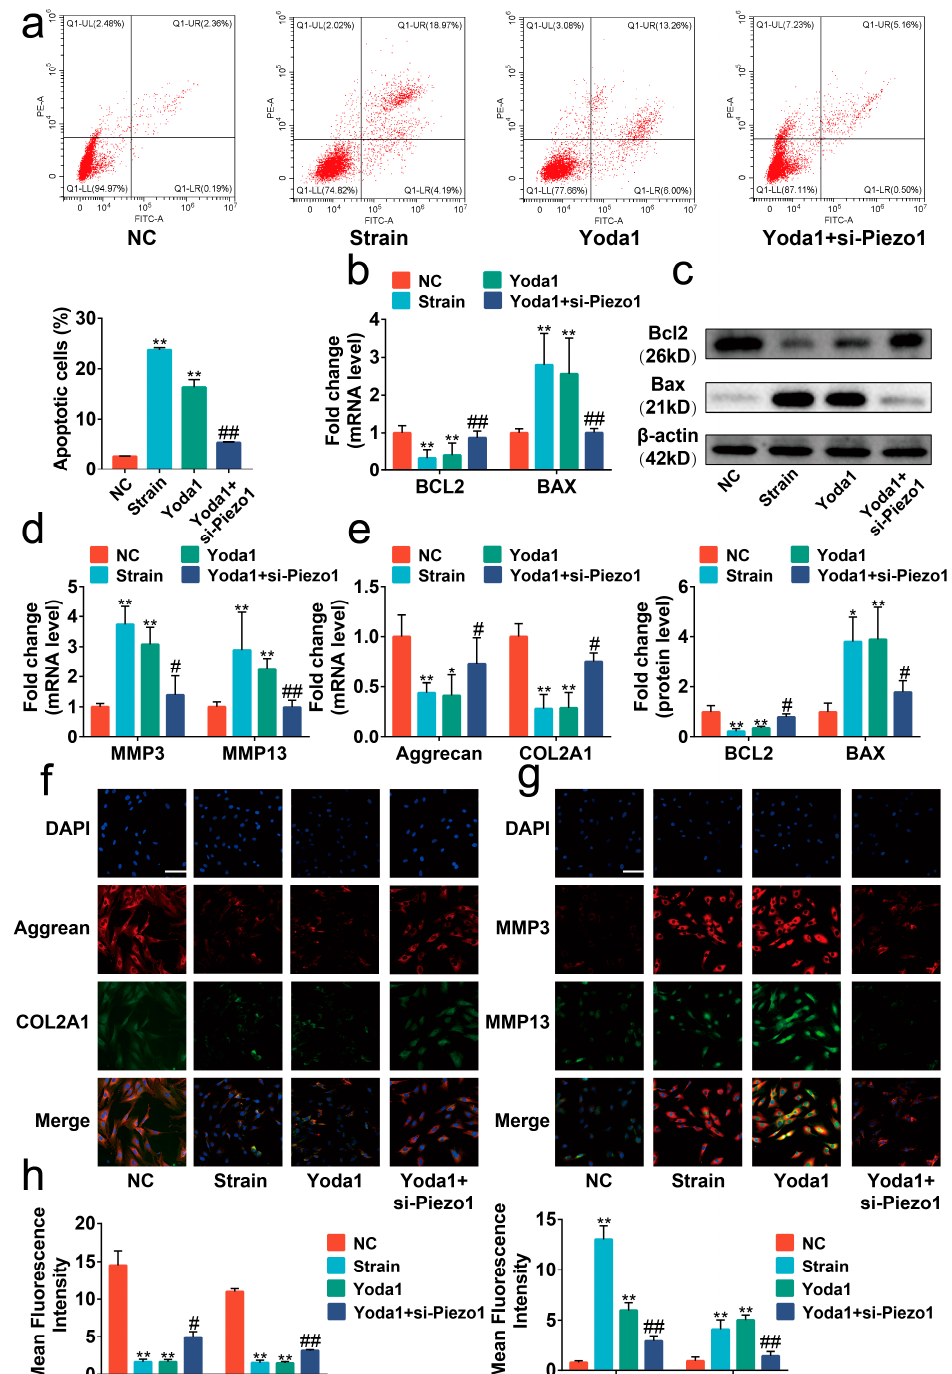
Figure 3. Mechanical strain induced the apoptosis and anabolic/catabolic imbalance in chondrocytes through Piezo1. ( a ) Flow cytometry analysis of chondrocyte stained with Annexin V-FITC and PI ( n = 3). ( b ) RT-qPCR analysis of BAX and BCL2 in chondrocytes ( n = 3). ( c ) Protein level of BAX and BCL2 determined by Western blots in chondrocytes ( n = 3). ( d , e ) RT-qPCR analysis of